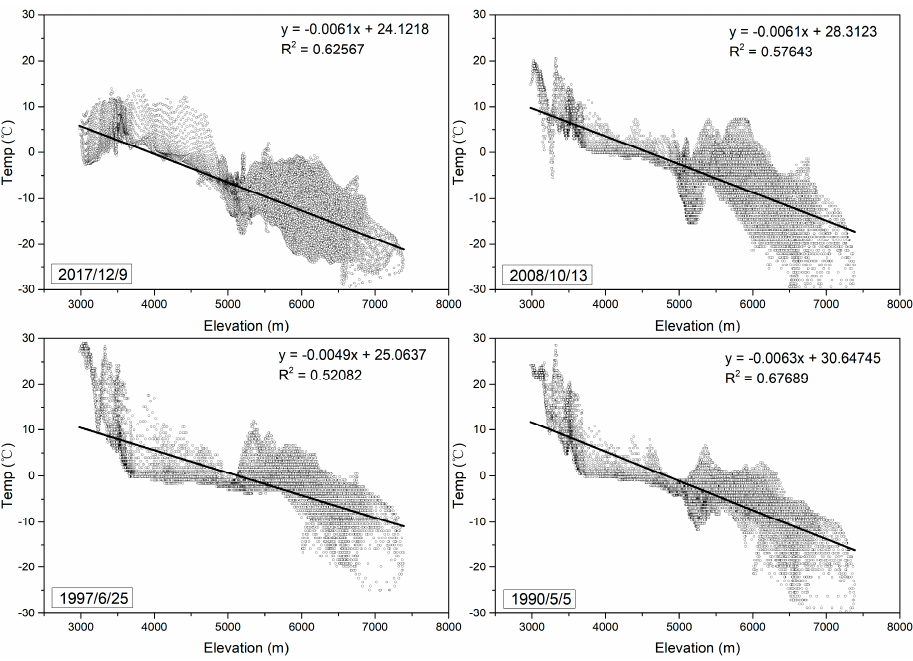
Figure 3. Spatial patterns of surface temperatures on the Hailuogou glacier in clear daylight (10 November 2018): ( a ) the variation in the GSTs with elevation; ( b ) the distribution of GSTs across the Hailuogou glacier; ( c ) photograph of the glacier tongue.